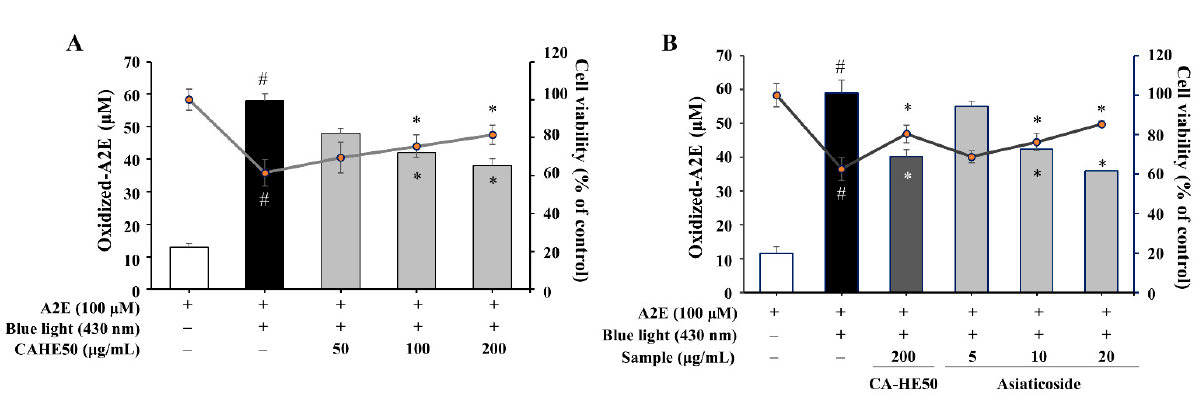
Figure 7. CA-HE50 and asiaticoside exhibit cytoprotective effects by inhibiting the accumulation of oxidized A2E in ARPE-19 cells through antioxidant activity. The cytoprotective efficacy of ( A ) CA-HE50 and ( B ) asiaticoside by the inhibition of oxidized-A2E production and accumulation. # p < 0.05 vs. normal control group. * p < 0.05 vs. A2E-treated group. Abbreviations: A2E, N -retinylidene- N -retinylethanolamine.